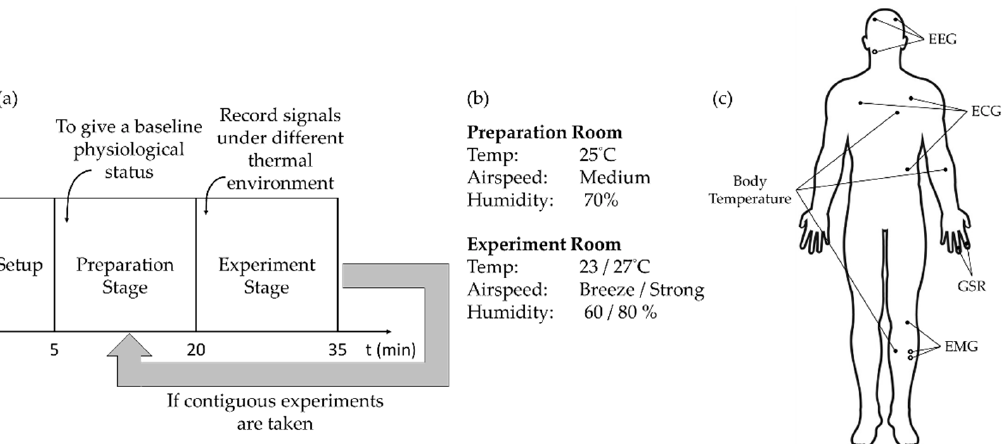
Figure 3. Experiment setups: ( a ) experiment procedure, ( b ) environment settings, and ( c ) measured